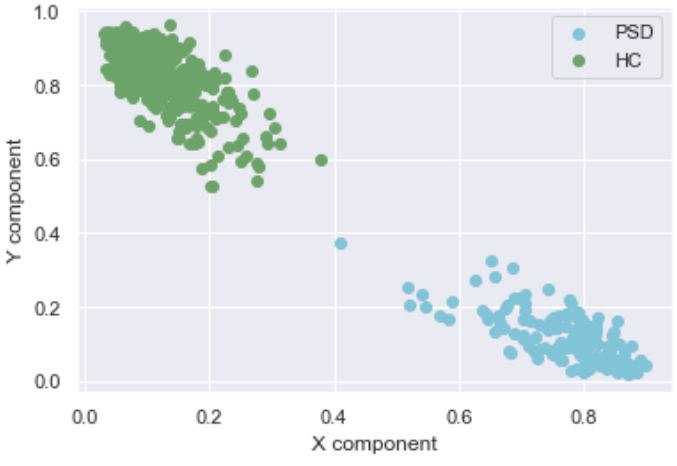
Figure 4. Feature space for disease